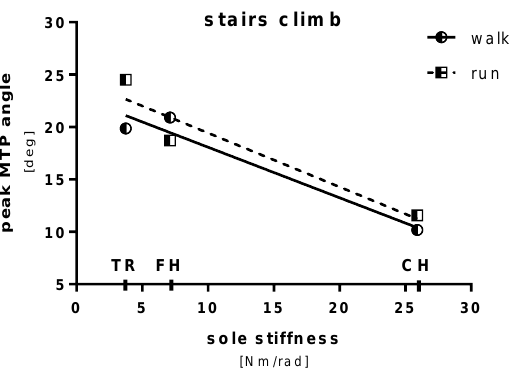
Figure 5. Results of the second campaign of data acquisition. Peak MTP angle versus shoe sole stiffness parametric in the speed of climbing of the stairs.